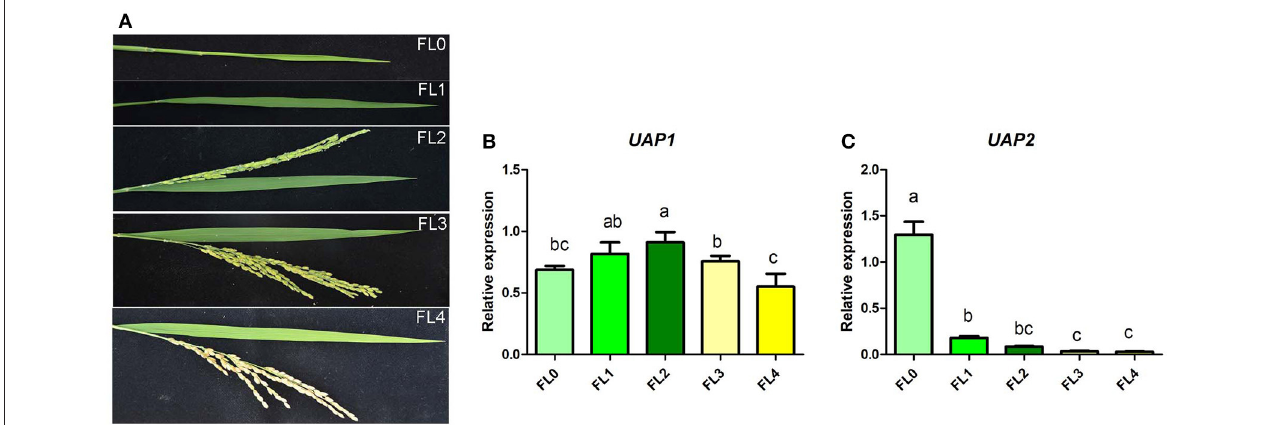
FIGURE 7 | Relative expression of the UAP1 and UAP2 genes during flag leaf development. (A) Flag leaf phenotype at unexpanded young leaf stage (FL0), booting stage (FL1), flowering stage (FL2), filling stage (FL3), and maturation stage (FL4). (B,C) Relative expression levels of the UAP1 and UAP2 genes. Data represent the mean ± SD of three biological replicates, and lowercase letters above columns indicate the statistically significant difference among all samples (one-way ANOVA). Relative expression of genes by qRT-PCR is normalized with reference genes UBC , Profilin-2 , and ARF